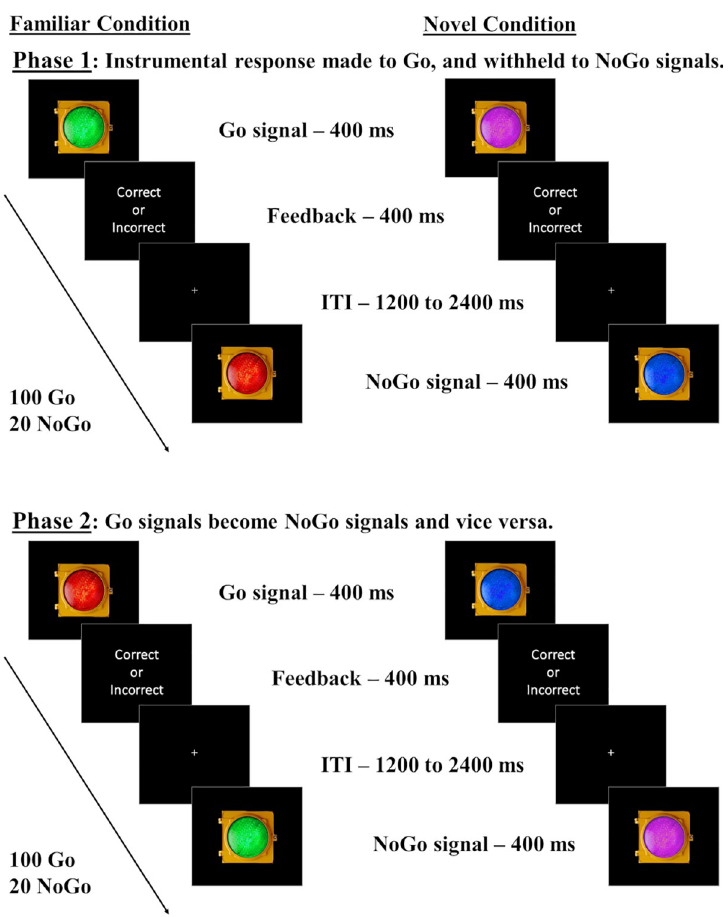
Fig 1. Go/NoGo task with familiar and novel lights. Participants are assigned to Familiar or Novel conditions. In the Familiar condition, subjects complete two phases: one where green signals Go and red signals NoGo (“congruent” mapping) and one where red signals Go and green signals NoGo (“incongruent” mapping). In the Novel condition, participants complete two similar phases, but the colors are blue and purple, for which there should be no strong pre- existing associations with “stop” and “go” responses. We predicted more commission errors in the Familiar condition for incongruent than congruent mappings, indicating outcome insensitivity, with no such within-subject differences expected in the Novel condition. Mapping orders were counterbalanced across